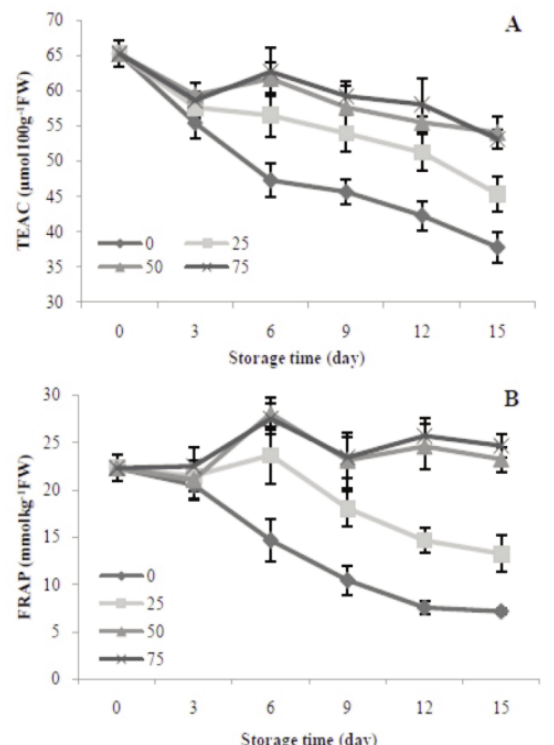
Fig. 3 ­ Antioxidant capacity with trolox equivalent antioxidant capacity (TEAC) (A) and ferric reducing antioxidant power (FRAP) (B) in figs ( Ficus carica L.) ‘Siyah’ fruit treated with Aloe vera gel (0, 25, 50 and 75%) during cold storage at 2°C. Vertical bars represent standard error of means of three experiments with four replicates per experiment.